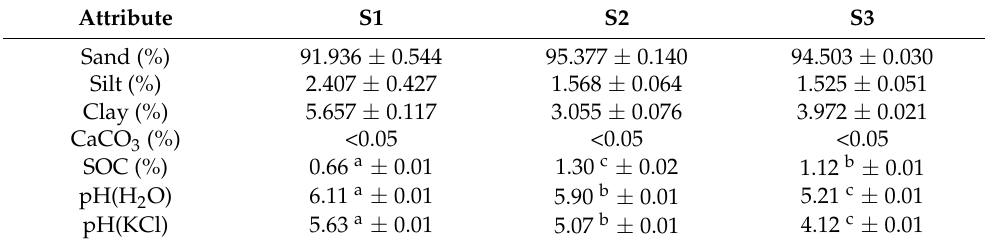
Table 1. Physical and chemical properties of the top (0–5 cm) soils taken from the experimental sites S1, S2, and S3. The results are presented in the form: arithmetic mean ± standard deviation. (SOC—soil organic carbon).